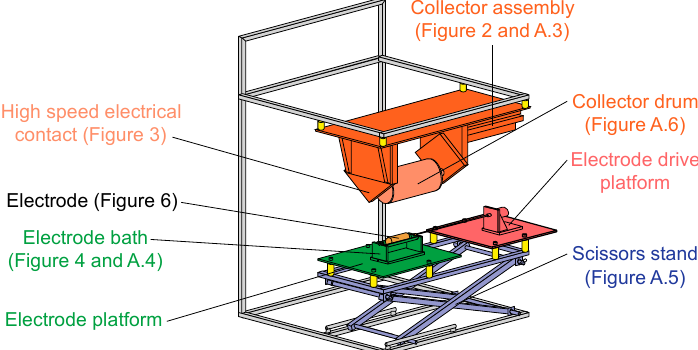
Figure 1. A schematic of our electrospinner device detailing parts and associated figures. A collector assembly (orange) hangs from a steel frame and positions a rotating collector drum (light orange). An electrode, from which electrospinning occurs, sits in an electrode bath on the electrode platform (green) which is rotated by a drive motor on the electrode drive platform (pink). A scissors stand (blue) allows the electrode to be raised and lowered relative to the collector drum.